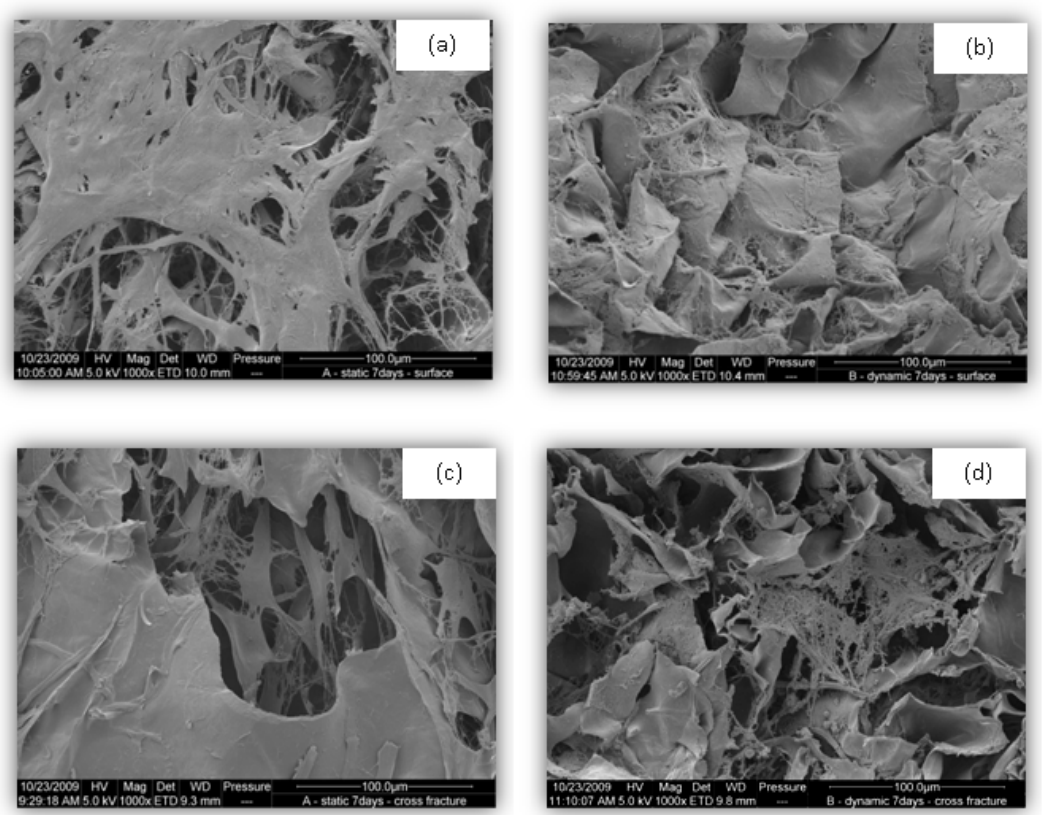
Figure 5. SEM images of OptiMaix-3D™ scaffolds—At the surface after static culture ( a ), after dynamic culture ( b ), and sample fragments after static culture ( c ), after dynamic culture ( d ). The scale bar represents 100